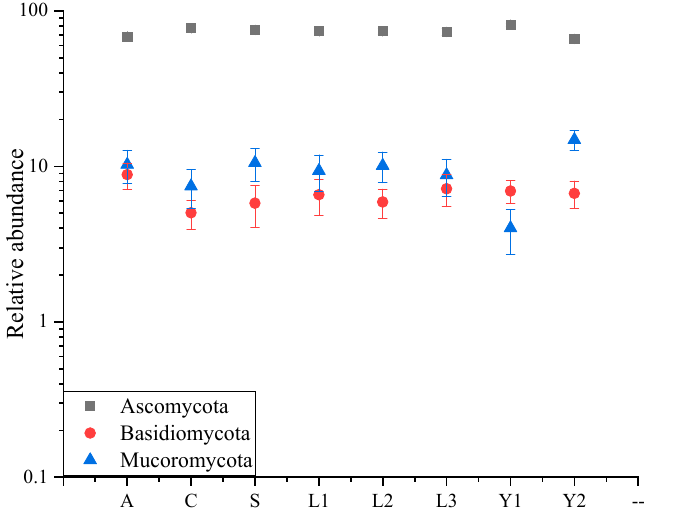
Figure 2. Relative abundance of fungi on rice grain. The relative abundance of Eumycota level, containing Ascomycota, Basidiomycota and Mucoromycota are represented by a square, circle and triangle, respectively.